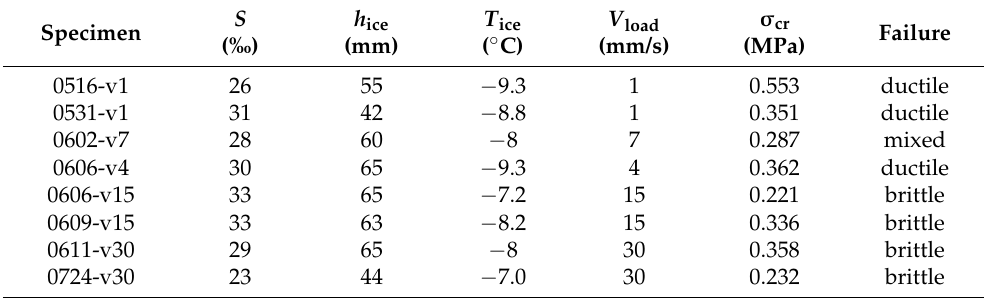
Table 1. Parameters of the indentation test.